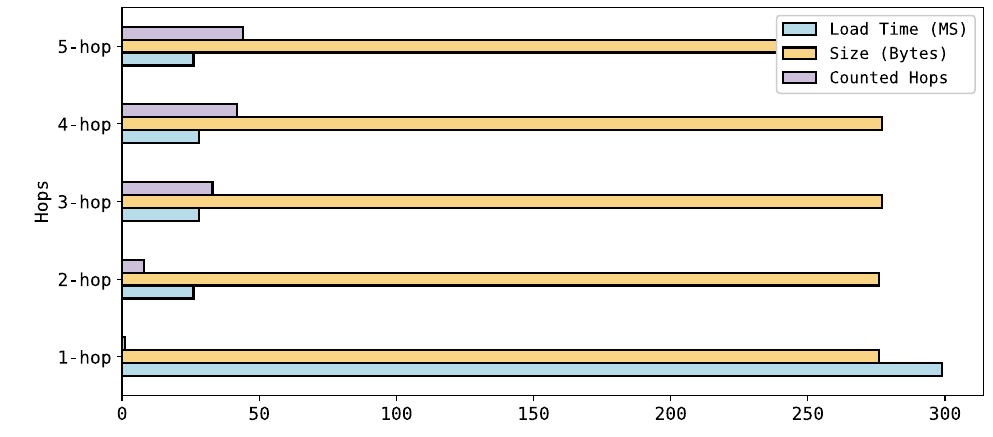
Figure 11. The results for the K-hop queries from Query1 to